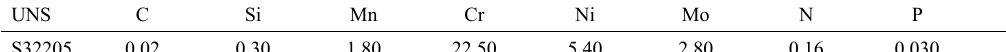
Table 1. Chemical composition (wt.%) of UNS S32205 duplex stainless steel.